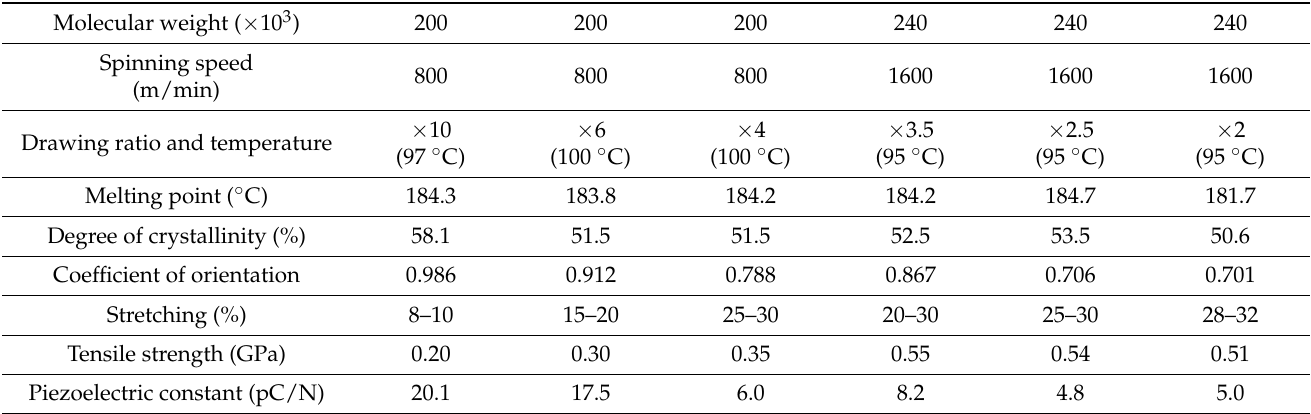
Table 1. Physical properties of PLLA